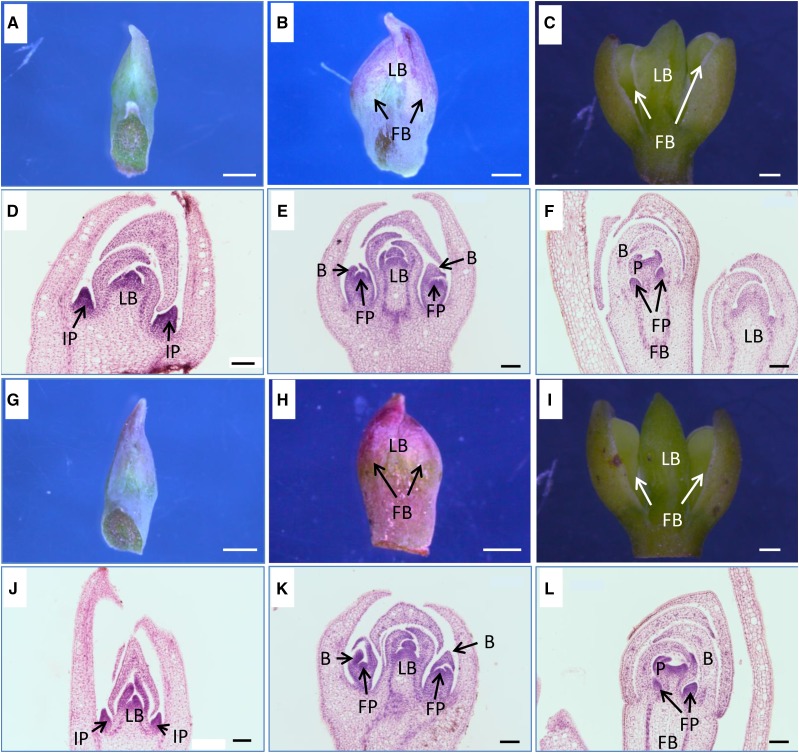
Anatomical characteristics in female and male floral bud differentiation of L. cubeba. Abbreviations: LB, leaf bud; FB, floral bud; IP, inflorescence primordium; FP, flower primordium; B, bract; P, perianth. (A-F) female floral bud; (G-L) male floral bud; (A, D, G, J) the inflorescence primordium begins to differentiate in the initial stage of floral bud differentiation; (B, E, H, K) the flower primordium begins to differentiate in the middle stage of floral bud differentiation; (C, F, I, L) the floral organs begin to differentiate in the later stage of floral bud differentiation. Bars = 1mm in A, B, C, G, H, and I; Bars = 100μm in D, E, F, J, K, and L.